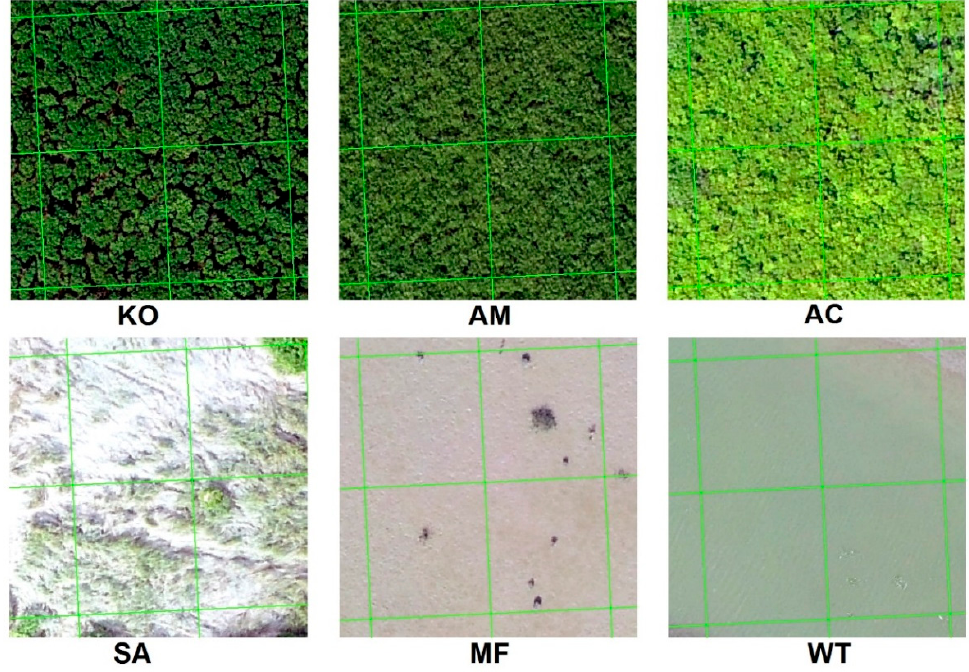
Figure 4. Examples of training samples selected by the adjusted fishnet and UAV images. KO: Kandelia Obovata , AC: Aegiceras corniculatum , AM: Avicennia marina , SA: Spartina alterniflora , WT: water, and MF: